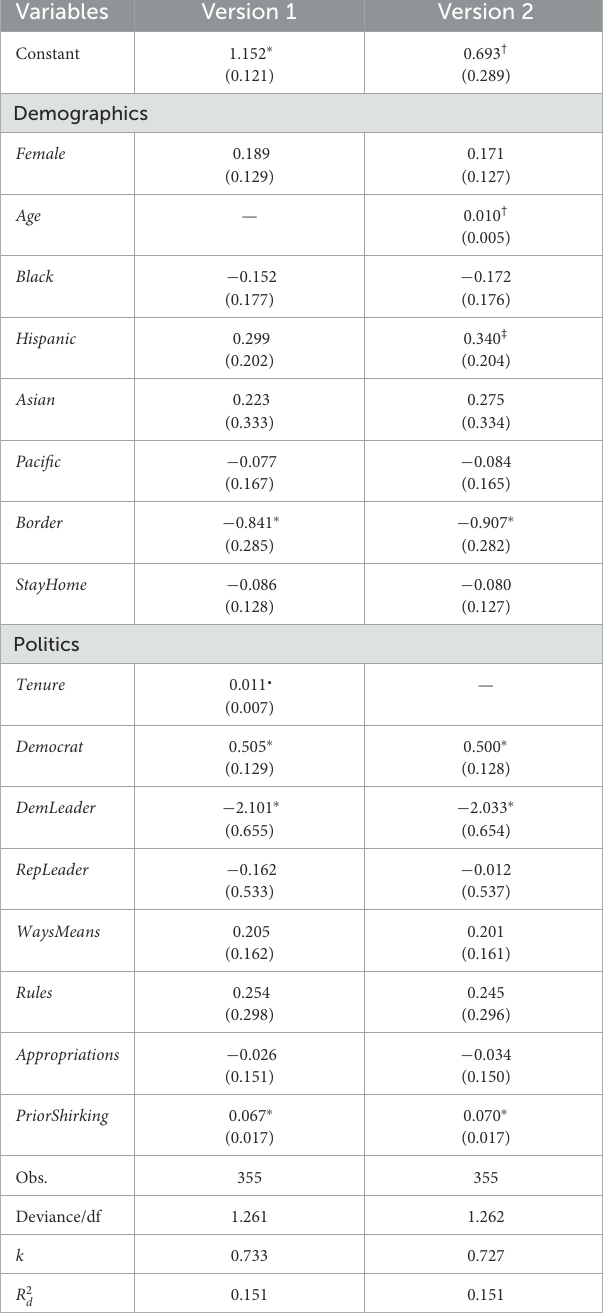
TABLE 2 Maximum likelihood estimates—negative